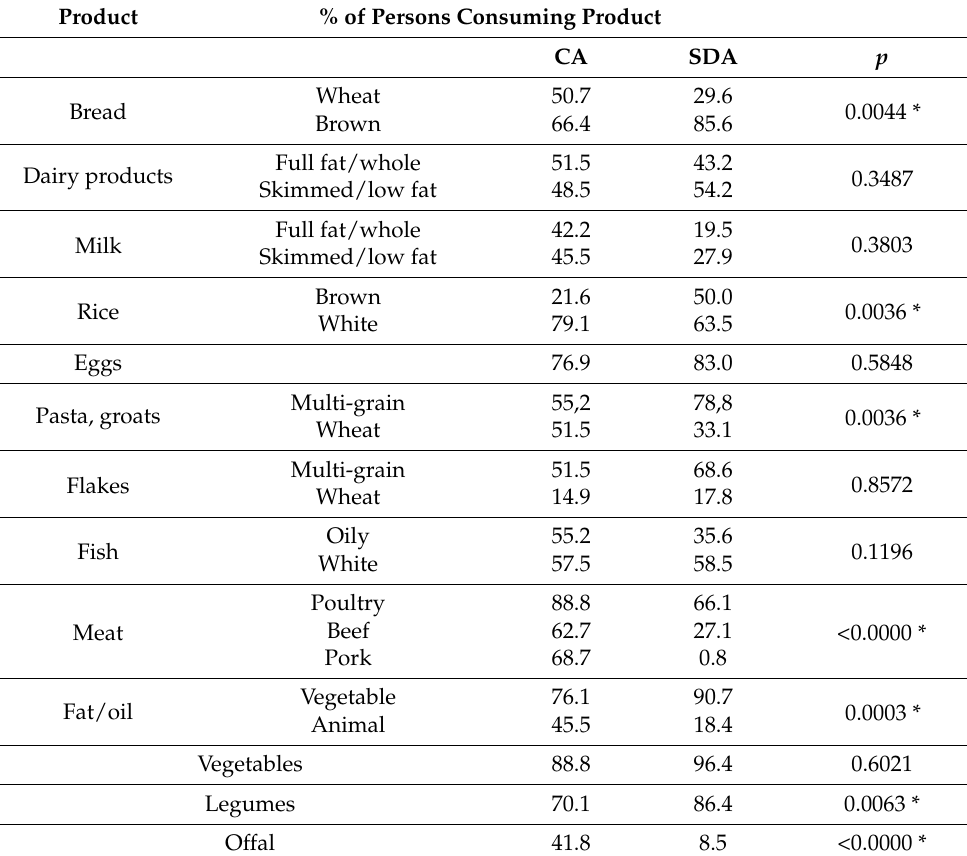
Table 3. Preferences of studied CA and SDA concerning consumption of selected food products.